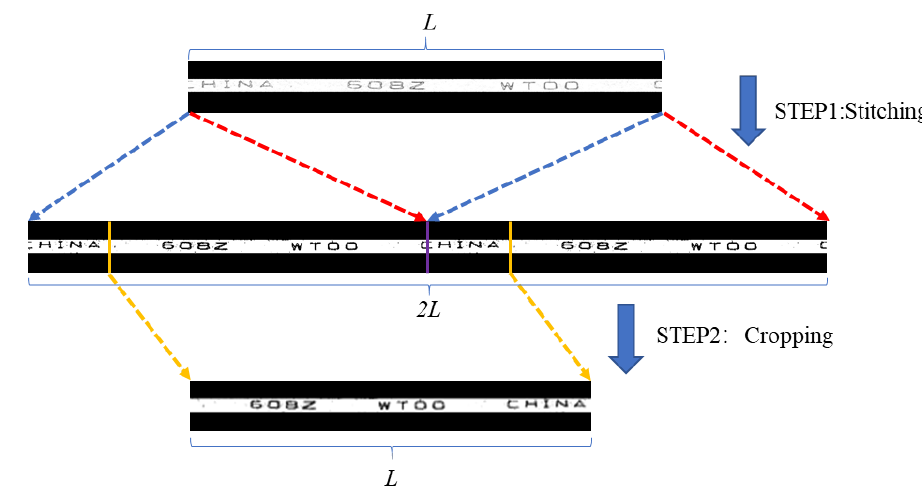
Figure 10. Image Self-Stitching-and-Cropping (ISSC) process. This method can effectively retain all the information of the original image without adding redundant information. Figure 11 and Algorithm 1 shows the